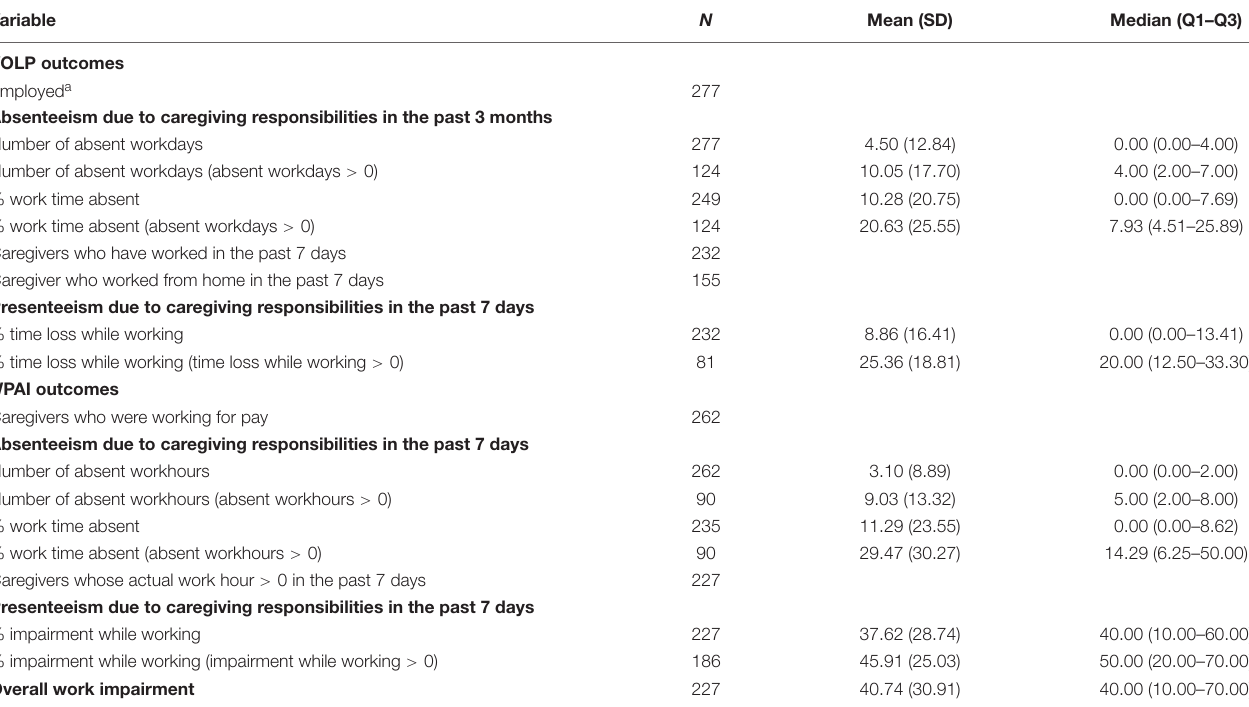
TABLE 2 | VOLP and WPAI